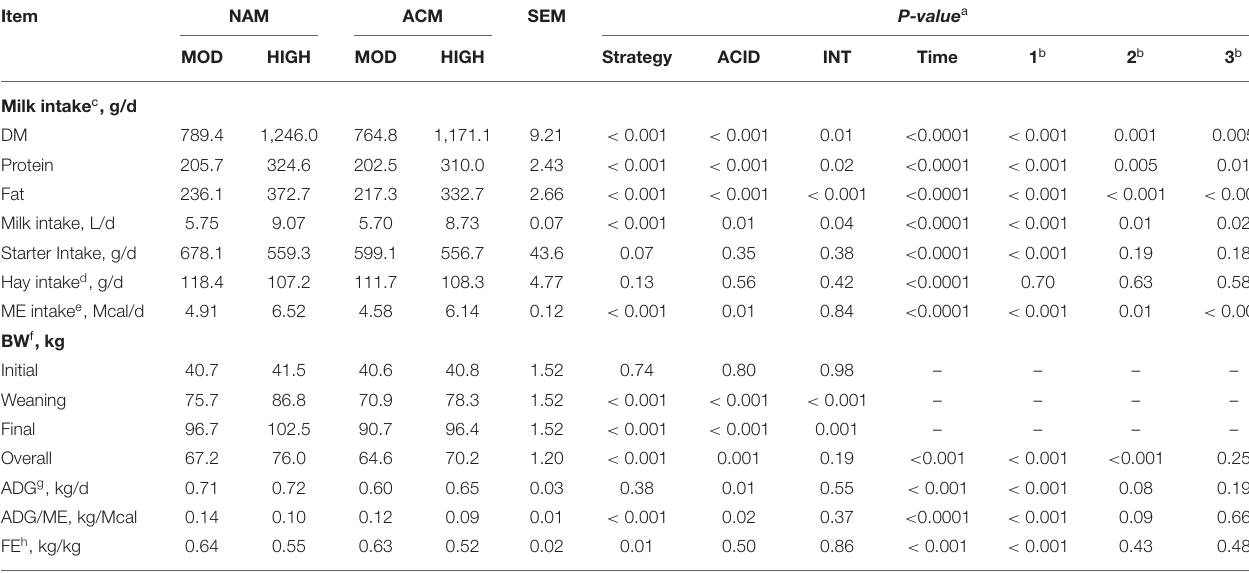
TABLE 3 | Least square means for the effect of milk feeding strategy and milk acidification on starter, hay (offered from day 64 to 78) and metabolizable energy intake for calves fed 6 (MOD) or 12L (HIGH) of milk with (ACM) or without (NAM) acid. Item NAM ACM SEM P-value a HIGH Strategy